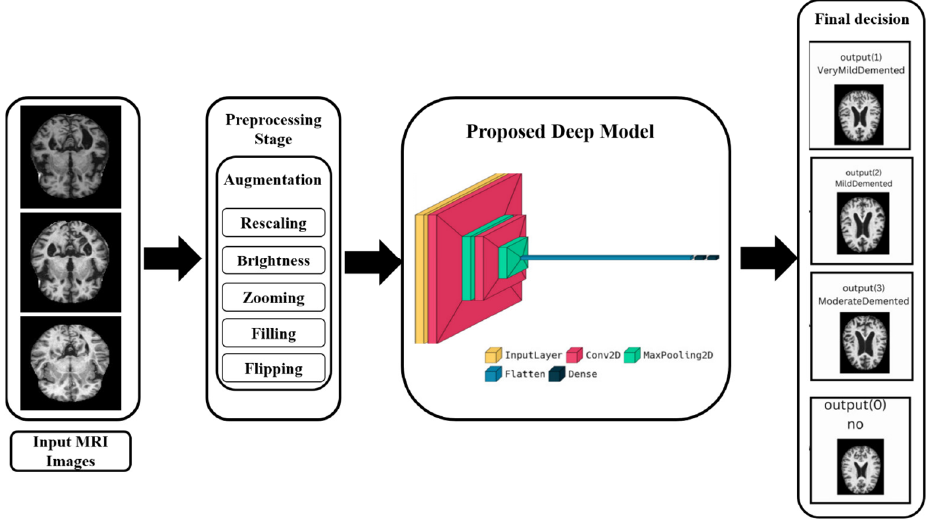
Figure 3. Block diagram of all stages of our method.